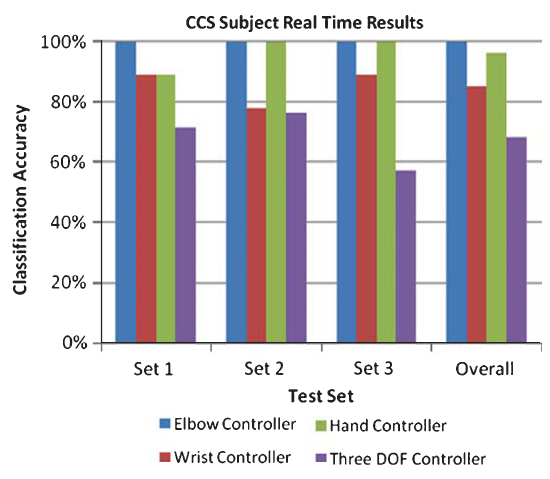
Fig. 9. Real time test results of all four controllers for the CCS subject shown as individual test sets and overall averages.